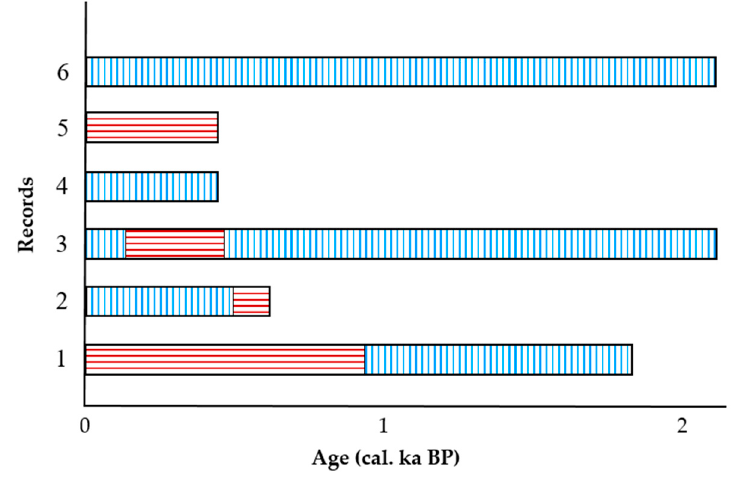
Figure 7. Late Holocene climate changes in northeastern Mongolia recorded from (1) Tuul River basin [this study], (2) Terelj River basin [this study], (3) Khuder River basin [16], (4) Lake Khagiin Khar basin [35], (5) Lake Gun basin [36], and (6) Shaamar area [37]. The vertical lines indicate the humid climate, but the horizontal lines indicate the arid climate.